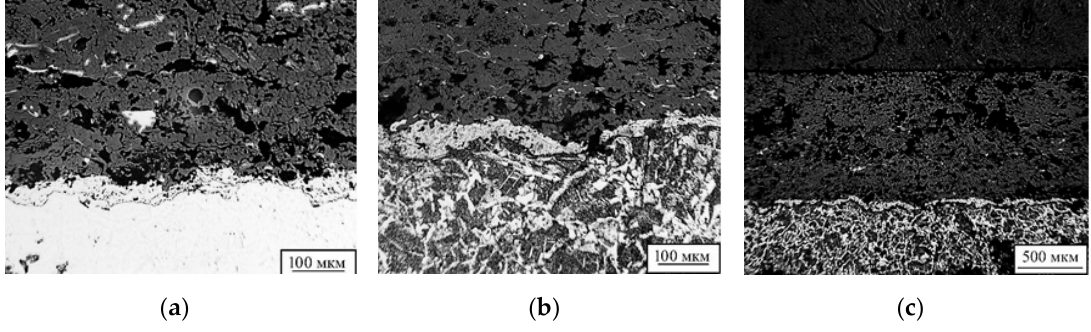
Figure 9. The study of the microstructure of the recovered samples: ( a ) sample without etching; ( b ) sample after etching; ( c ) plasma spraying.